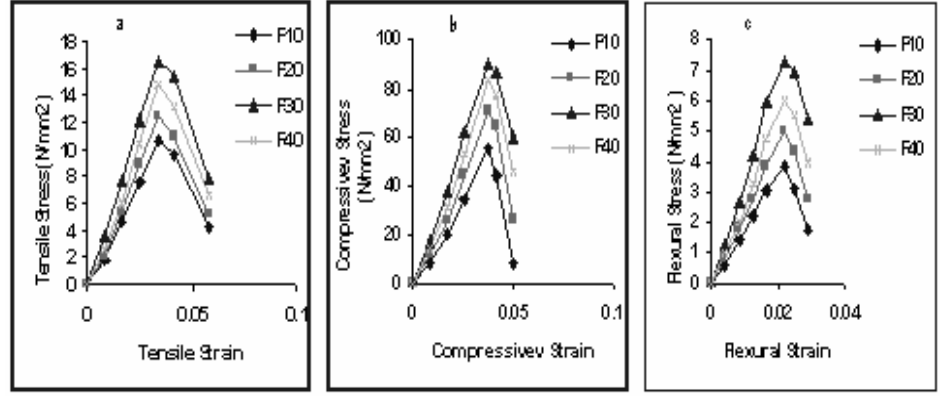
Figure 3. Stress strain curves of composites under tensile, compressive and flexural tests (a, b,